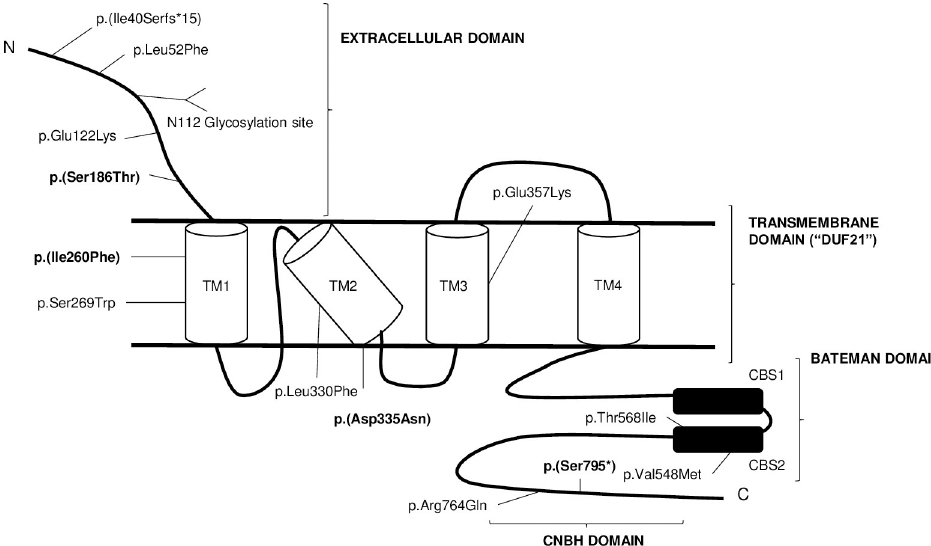
Fig 1. Schematic representation of CNNM2 protein at the plasma membrane, representing the position of thirteen variants. Variants marked in bold have not been reported to date. The CNNM2 protein structurally contains an N-terminal extracellular domain with one glycosylation site (asparagine residue N112); a transmembrane domain (“domain of unknown function 21” or DUF21) with four predicted transmembrane α -helices (TM1-4); and a cytosolic region with two domains: the CBS-par domain (Bateman domain) and the cyclic nucleotide-binding homology domain (CNBH).